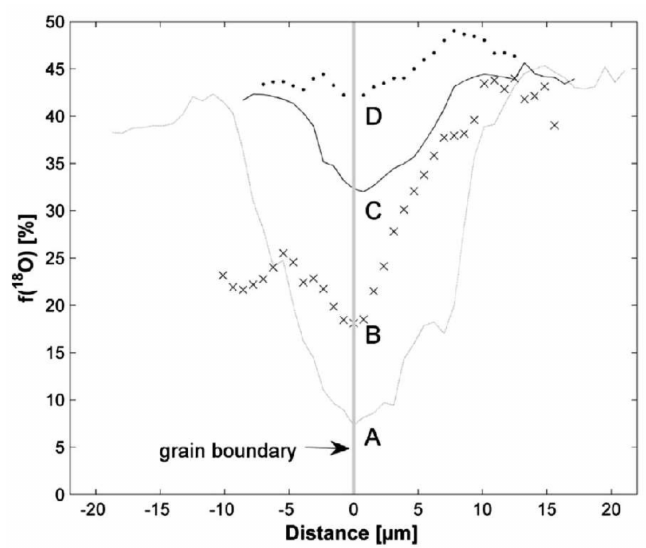
Figure 4. Backscattered electron image of calcite crystals within a cube of Carrara marble that have been partially replaced by apatite (bright phase). Top image shows the location of four line profiles measured using Raman spectroscopy that are depicted in the bottom graph. Isotopic enrichment increases along line A away from the grain contact (labelled grain boundary). Whereas, the apatite at the grain contact probed by line D shows the same level of isotopic enrichment as ~10 µ m into the apatite rim along line A. Reprinted from Earth and Planetary Science Letters, vol. 386, Jonas et al., “The role of grain boundaries and transient porosity in rocks as fluid pathways for reaction front propagation”, pages 64–74, (2014), with permission from Elsevier